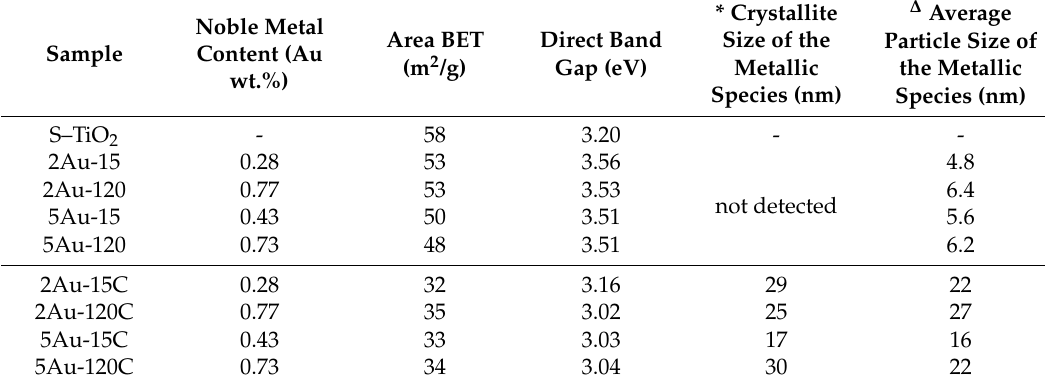
Table 1. Miscellaneous physico-chemical properties of the prepared materials including: noble metal content, specific area BET, band gap, and particle sizes of the metal nanoparticles. Noble Metal Sample Content (Au